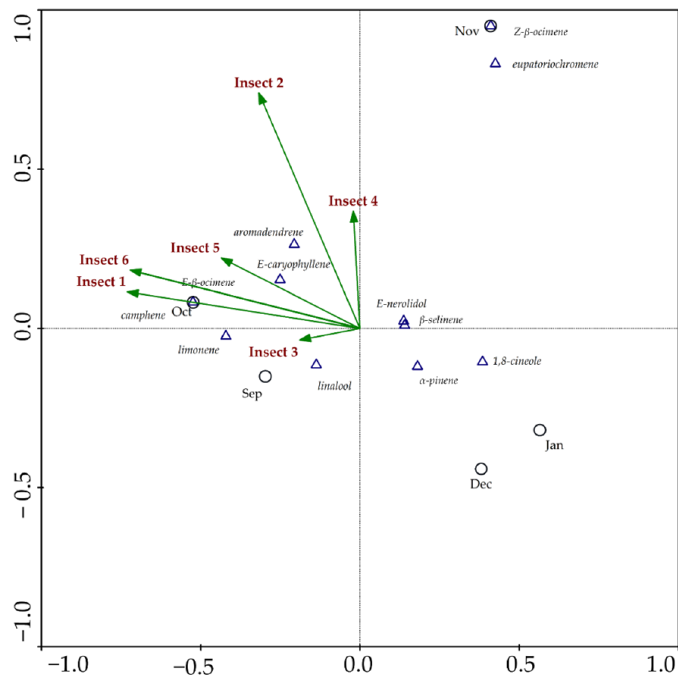
Figure 3. Canonical Correspondence Analysis (CCA) that correlates the chemical composition of foliar essential oils and the frequency of visits of potential pollinators of Piper mollicomum Kunth from Jan–January; Insect 1 (Diptera— Syrphidae sp. 1); Insect 2 (Hymenoptera— Tetragonisca angustula Latreille. 1811); Insect 3 (Diptera— Syrphidae sp. 2); Insect 4 (Hymenoptera— Halictidae sp. 1); Insect